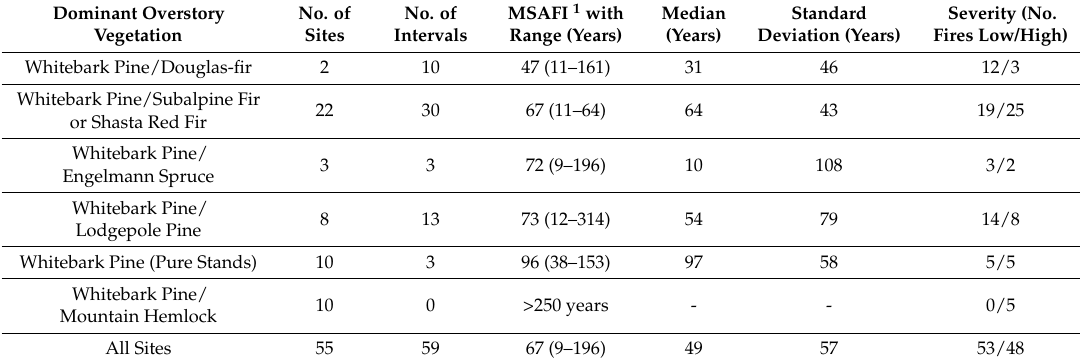
Table 3. Comparison of fire intervals and severities for each overstory forest community type.